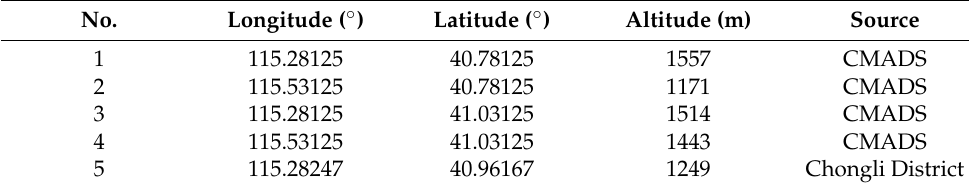
Table 2. The geographic information of the meteorological stations. No. Longitude ( ◦